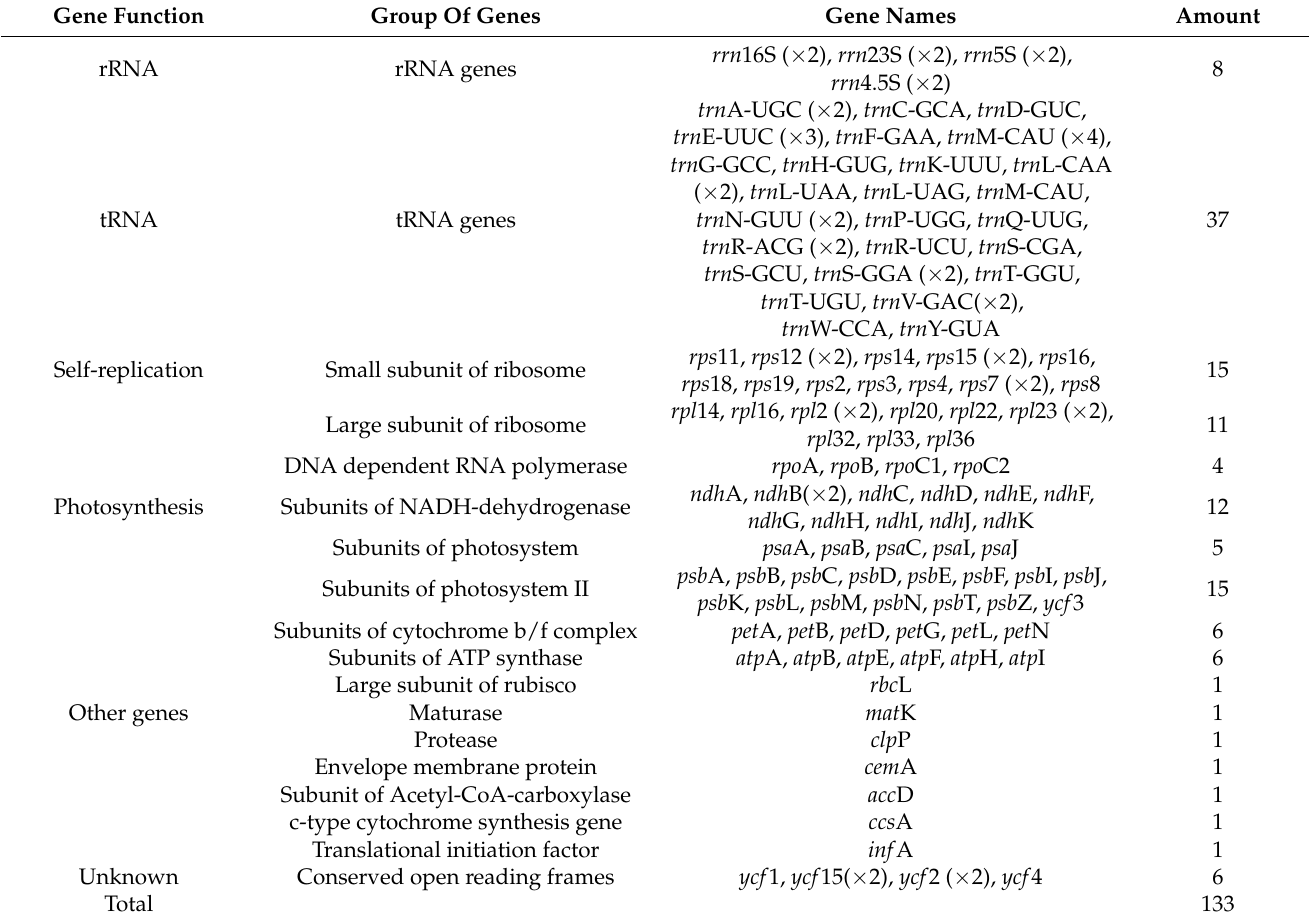
Table 2. Gene contents of O. taihangensis and O. longilobus cp genome.